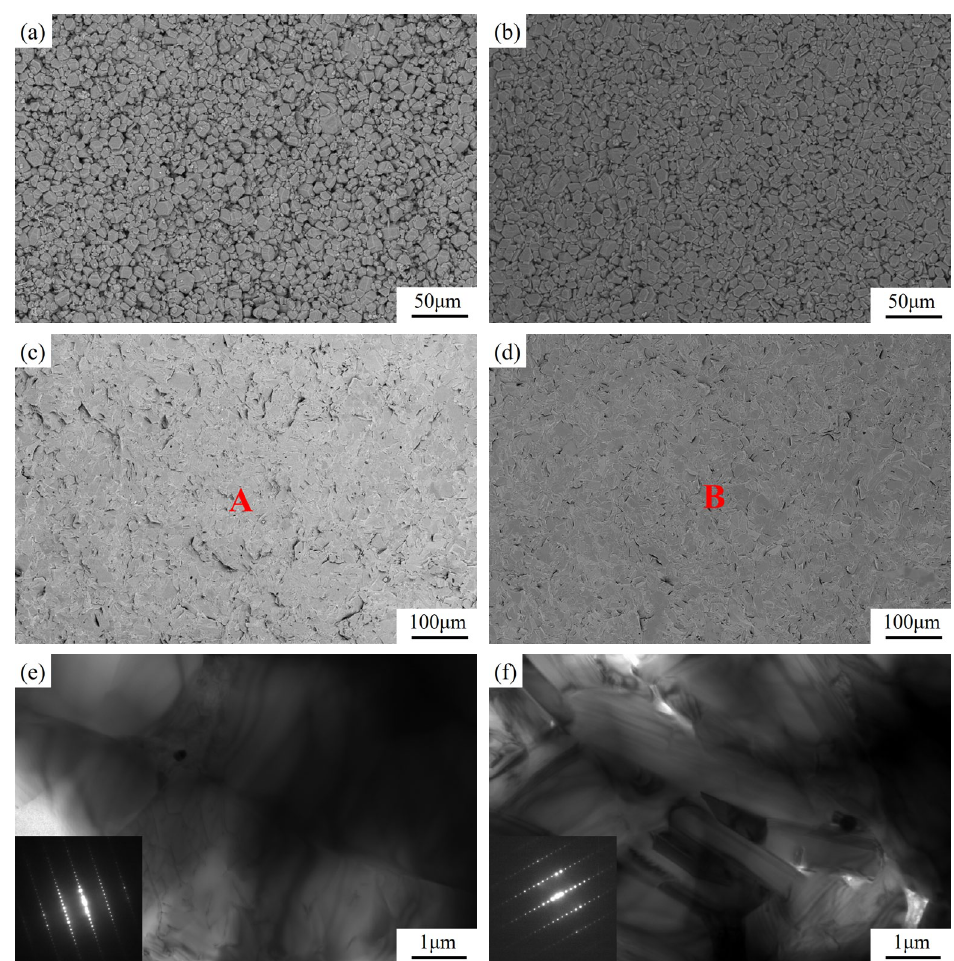
Fig. 4 SEM images of CM 2 A 8 and C 2 M 2 A 14 bricks and ceramics, and TEM images and SAED results of CM 2 A 8 and C 2 M 2 A 14 ceramics. (a) SEM image of CM 2 A 8 brick; (b) SEM image of C 2 M 2 A 14 brick; (c) SEM image of CM 2 A 8 ceramic; (d) SEM image of C 2 M 2 A 14 ceramic; (e) TEM image and SAED result of CM 2 A 8 ceramic; (f) TEM image and SAED result of C 2 M 2 A 14 ceramic.